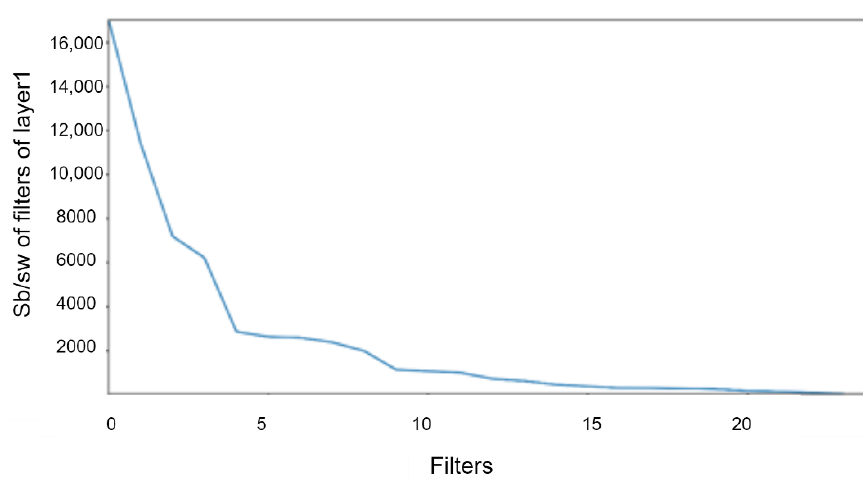
Figure 2. Selection of best filters for layer1 of DeepFKTNet model for FingerPass dataset.